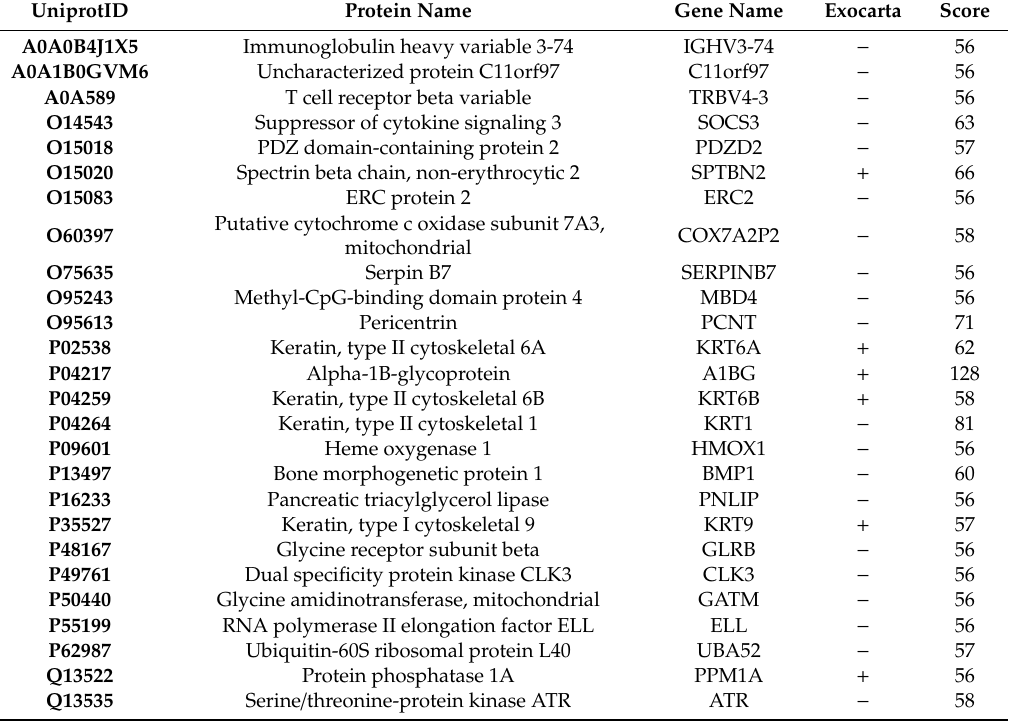
Table 7. Unique Exosomal Proteins Identified in Total Blood of